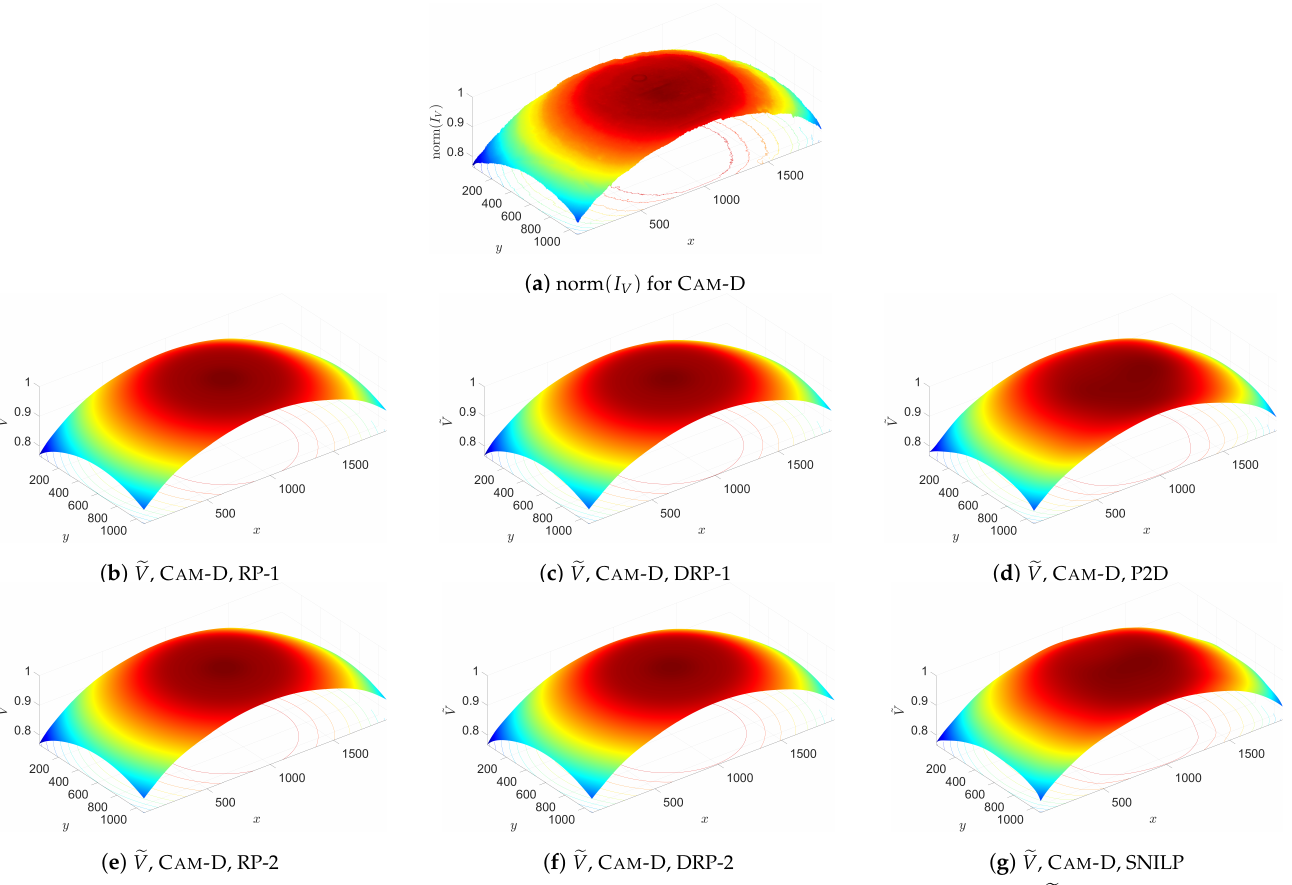
Figure A7. Comparison of vignetting image I V and vignetting estimates (cid:101) V obtained for the tested models and C AM -D.